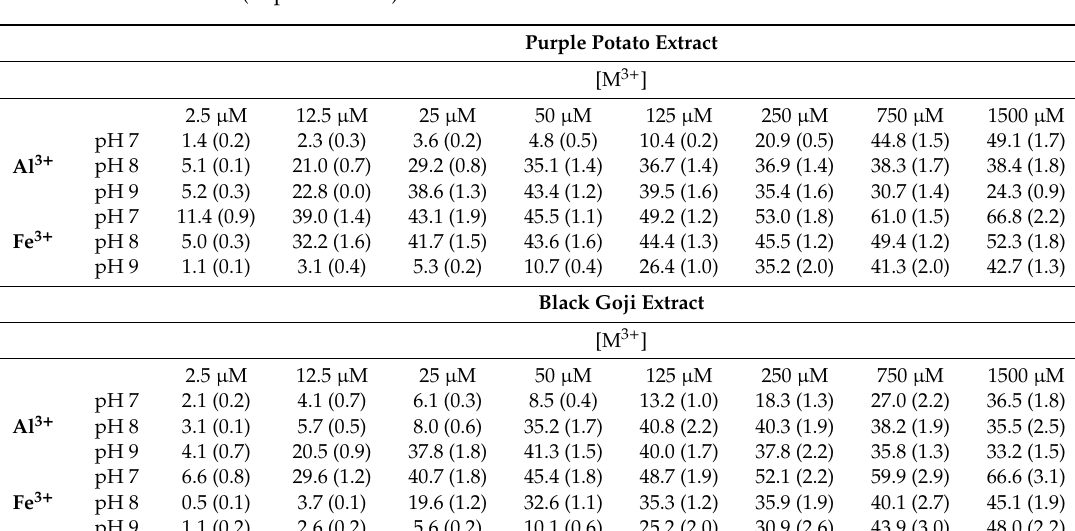
Table 2. Color changes ( ∆ E* ab ) of the petunidin derivatives with increased metal ion concentration in alkaline conditions (pH 7–9) after 60 minutes of equilibration. Data are presented as the mean and standard deviations (in